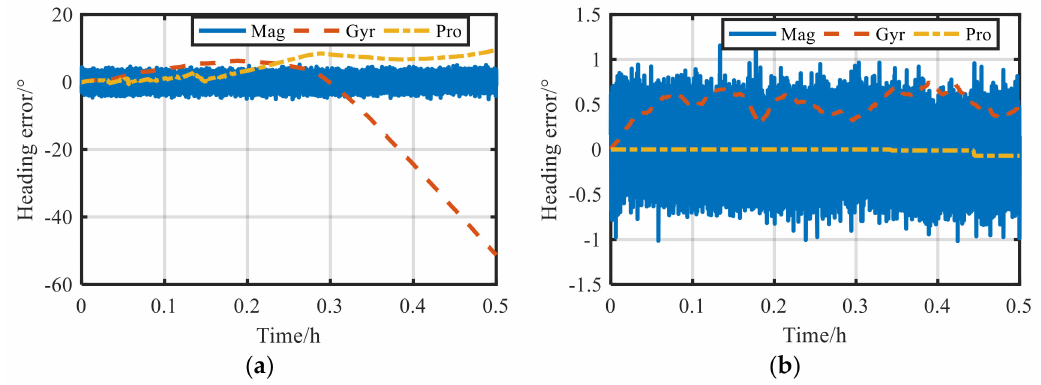
Figure 2. Heading error of static data for di ff erent methods: ( a ) The heading error of Huawei Honor V9 (HV9); ( b ) The heading error of XiaoMi8 (XM8).